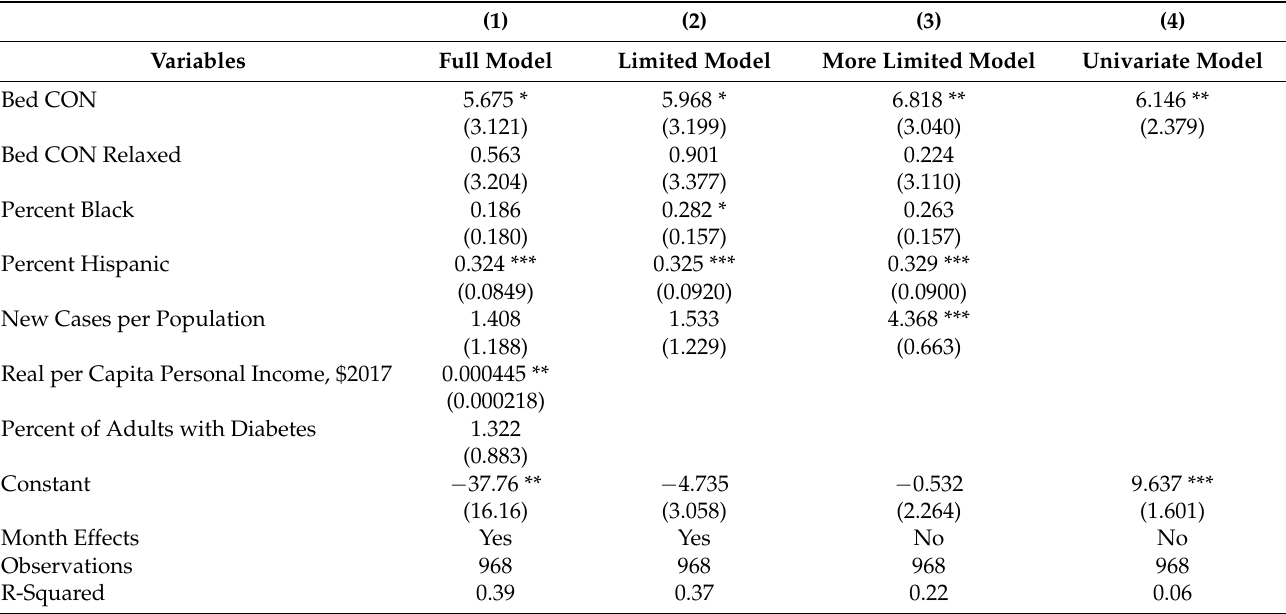
Table 6. Modeling the Number of Days in Which More than 70 Percent of Beds Used per Month per